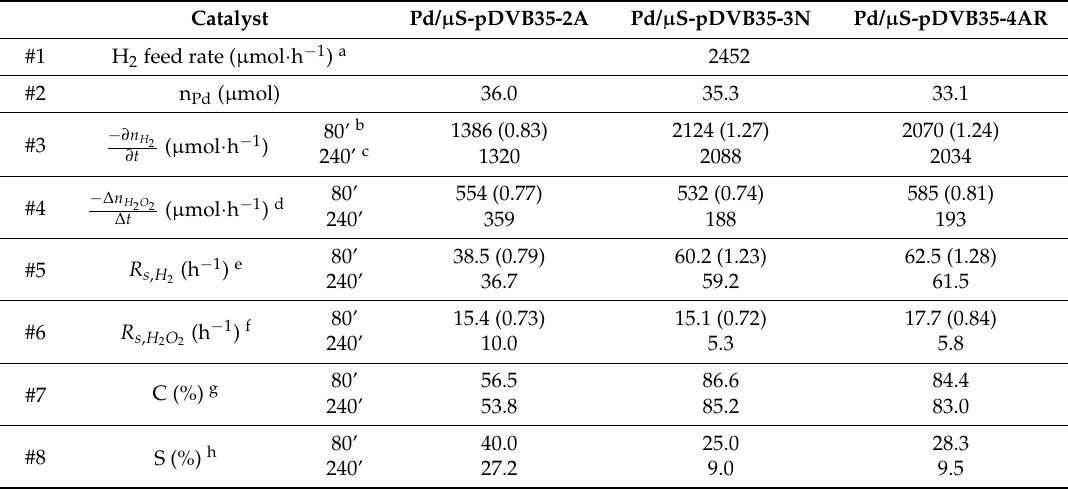
Table 4. Apparent and specific rates of H 2 consumption and H 2 O 2 formation (values relative to the fresh catalyst in parentheses) and the respective conversions and selectivities over aged Pd/ µ S-pDVB35 batches.